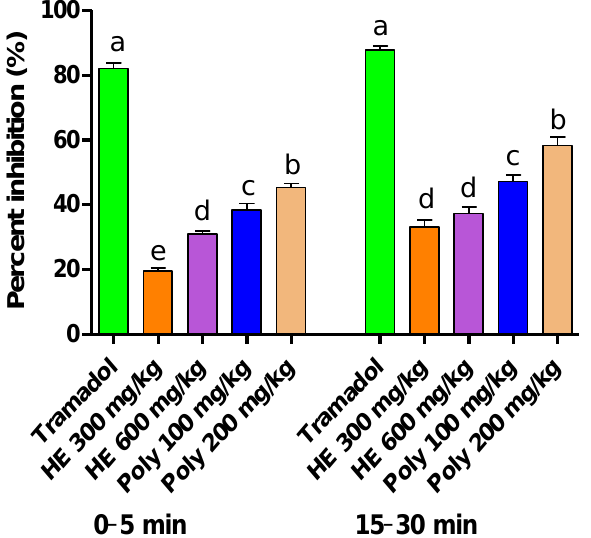
Figure 4. Percentage of inhibition of formalin-induced pain in mice upon the application of HE and polyphenolic extracts of L. officinalis Chaix and Tramadol (C+). The rates were calculated using the non-treated mice as a reference. The different letters in superscript (a,b,c,d) represent the treatment differences that are statistically significant p < 0.05. Table 5. Wound size in cm 2 after the treatment with the hydro-ethanolic and polyphenolic extracts of L. officinalis Chaix over 25 days.